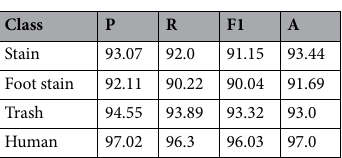
Figure 6. Human movement tracking, ( a – c ) human movements and ( d ) tracking result.